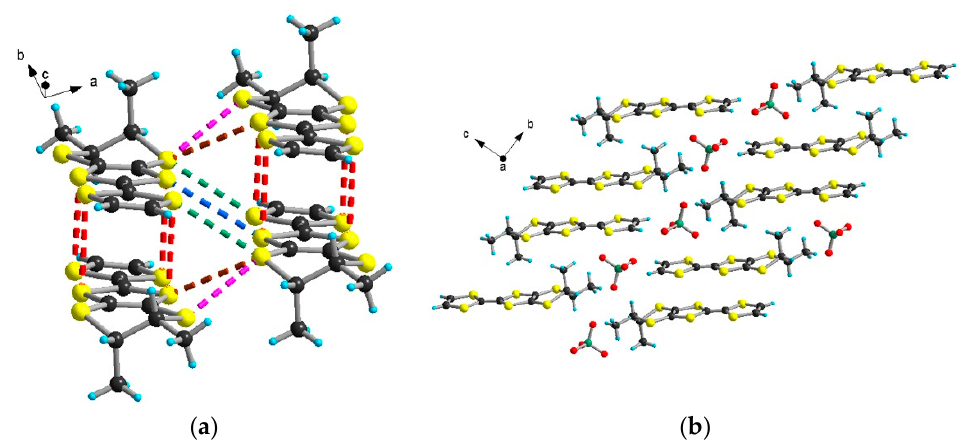
Figure 12. ( a ) Packing diagram for [( meso )- 2 ]ClO 4 in the ab plane with an emphasis on short S···S